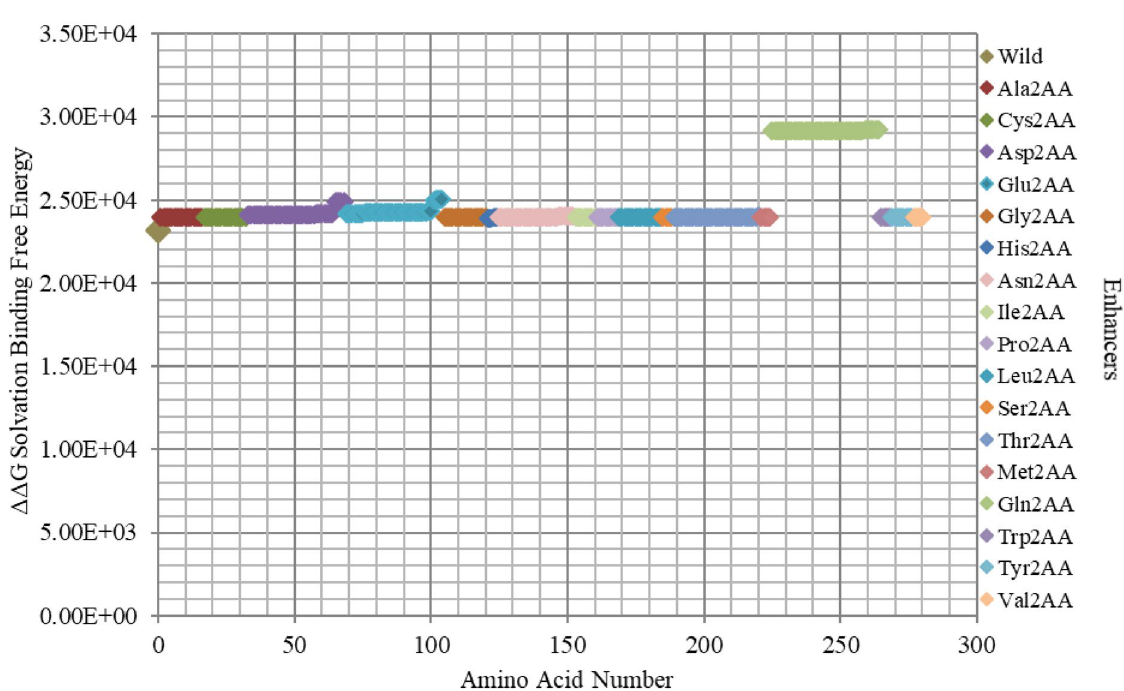
Figure 12. Electrostatic free energy differences of all GATA3 enhancers within GATA3:DNA complex. Plot presents the solvated binding free energy calculations (in KJ/mol) of all GATA3 amino acid mutants that are enhancers in both of Chain-C and